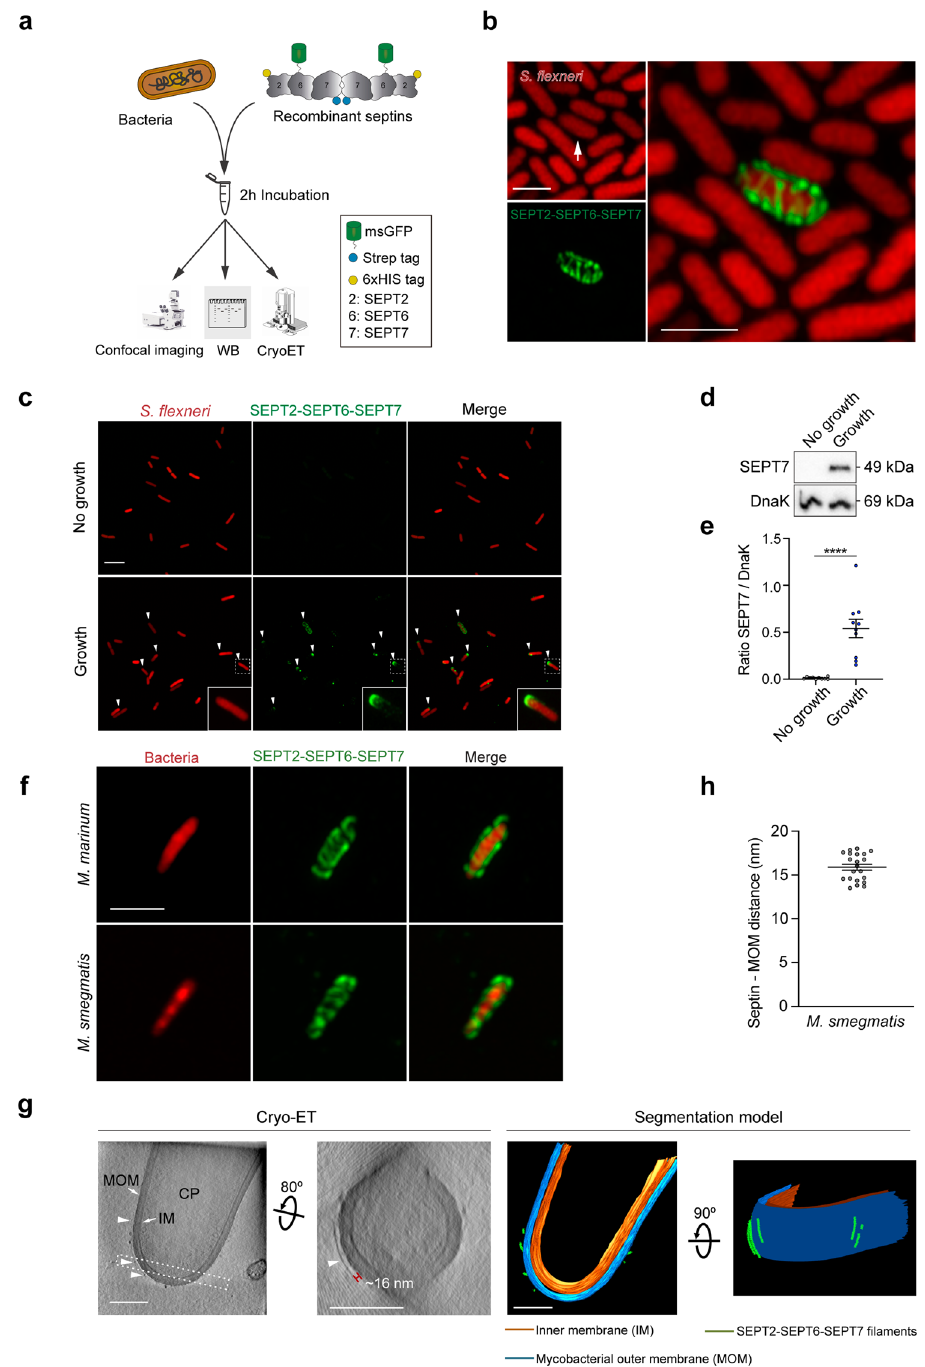
Fig. 1 Bacterial growth is essential for S. fl exneri recognition by septins. a Pipeline followed for the analysis of in vitro reconstituted septin cages. CryoET, cryo-electron tomography; WB, western blotting. b Representative Airyscan confocal image of a S. fl exneri 5a str. M90T septin cage reconstituted in vitro. White arrow, bacterial cell entrapped in a septin cage. Scale bar, 2 μ m. c Airyscan confocal images comparing septin binding in the absence (top) or presence (bottom) of bacterial growth. White arrowheads, bacteria binding polar septin complexes. This experiment was performed 10 independent times. Scale bar, 5 μ m. d , e Bacterial sedimentation assays of samples from panel ( c ). A representative blot is shown ( d ). e Graphs represent the mean ± SEM of the ratio SEPT7/DnaK (used as loading control) from 10 independent blots. **** p < 0.0001 by two-tailed Student ’ s t -test. f Representative Airyscan confocal images of M. marinum (top) and M. smegmatis (bottom) septin cages reconstituted in vitro. This experiment was performed 3 independent times. Scale bar, 2 μ m. g CryoET images of a M. smegmatis septin cage reconstituted in vitro (left, accession No. #EMD-12562). The corresponding segmentation models are shown in the right panels. Image shown corresponds to a slice of 10.8-nm thickness. CP, cytoplasm; MOM, mycobacterial outer membrane; IM, inner membrane. Arrowheads, septin fi laments. Dashed rectangle, bacterial cell area selected to show the septin fi lament. Scale bars, 200 nm. h Measured distance between septin fi laments and the M. smegmatis outer membrane. Data correspond to mean ± SEM from n = 21 fi laments from 3 independent tomograms.